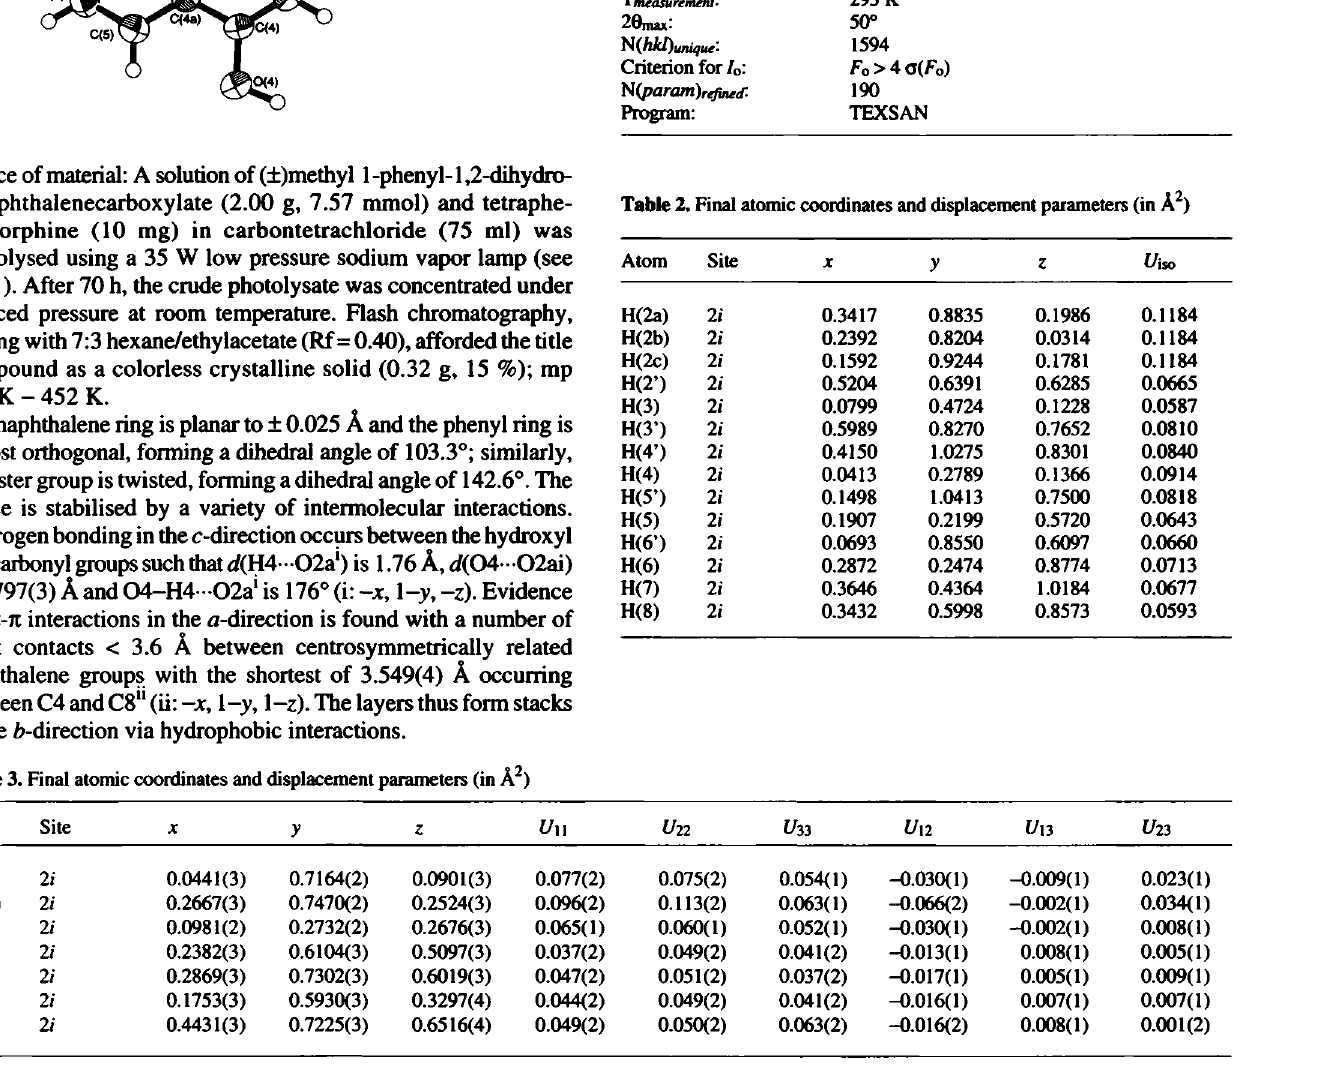
Table 3. Final atomic coordinates and displacement parameters (in Â^)